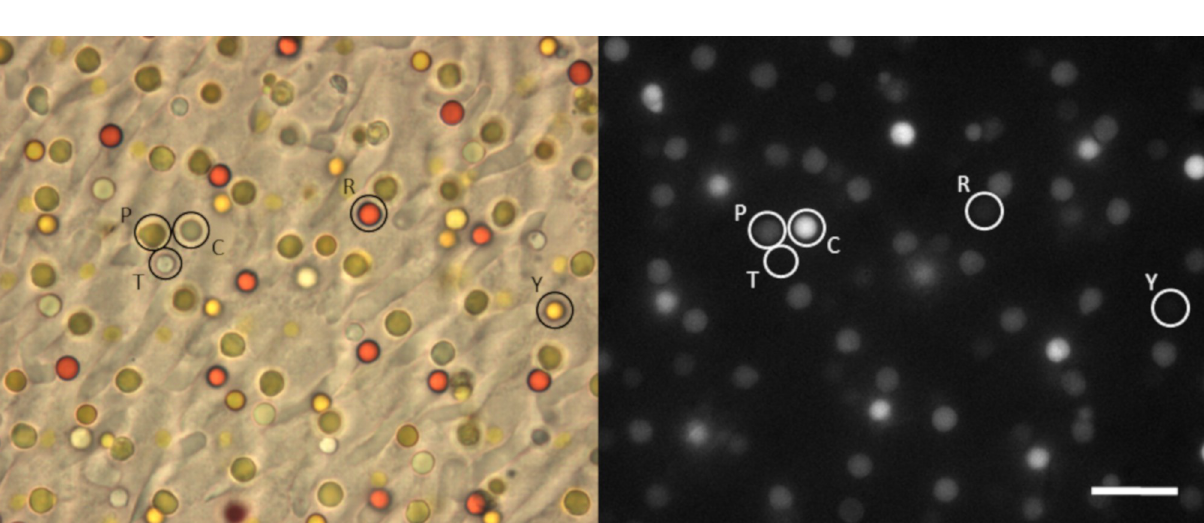
PLOS ONE | https://doi.org/10.1371/journal.pone.0217418 May 31,